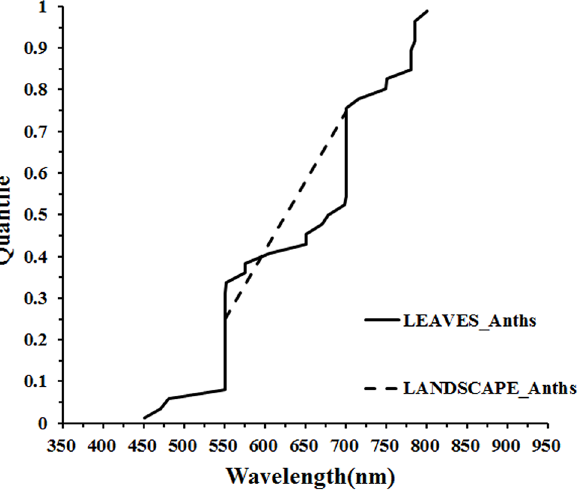
Fig 13. Quantile plot of the optimal wavelengths for the quantification of Anths at different